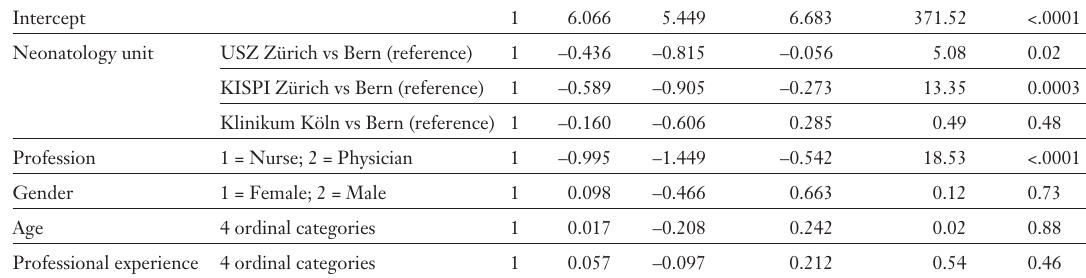
Differences in pain intensity assessment (multivariate analy-